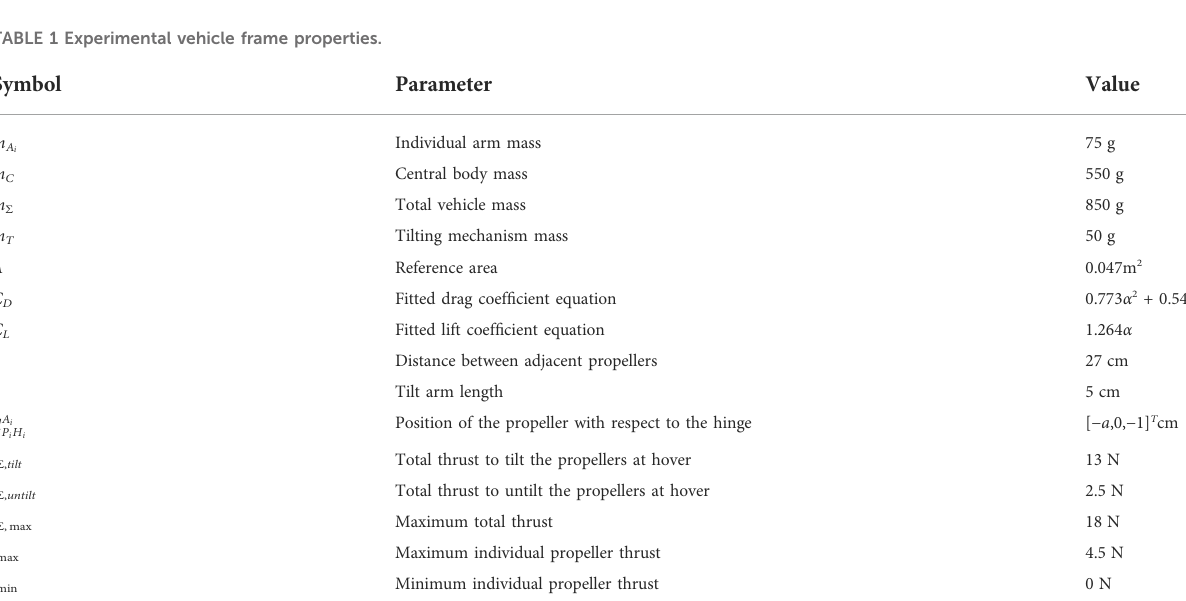
TABLE 1 Experimental vehicle frame